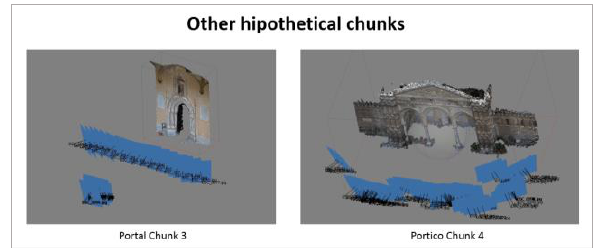
Figure 17. Data set for Portal and Portico